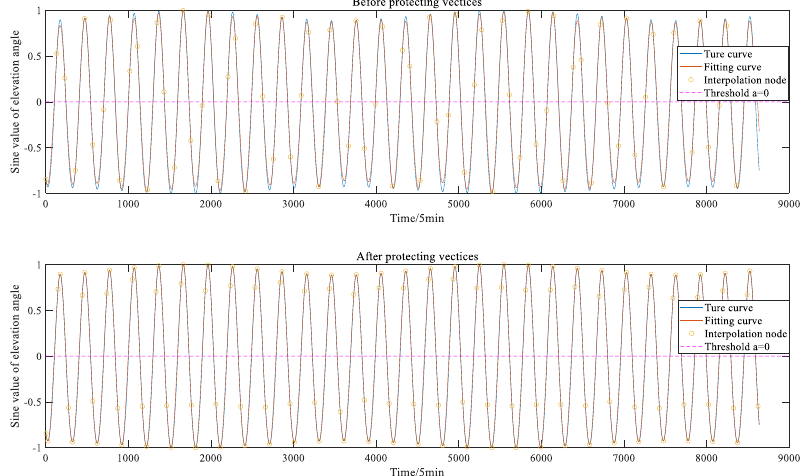
Figure 5. Effects of vertex protection algorithms on fitting of elevation angle functions.